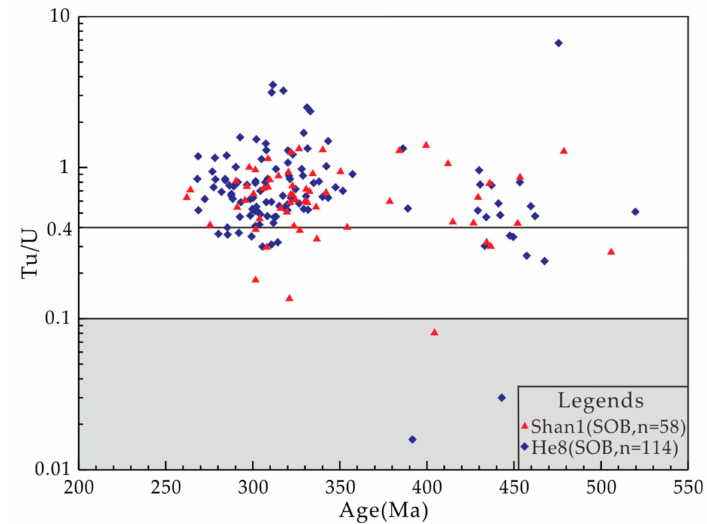
Figure 7. U-Pb age vs. Th / U ratio diagram. The shaded area denotes values for typical metamorphic zircons with Th / U <